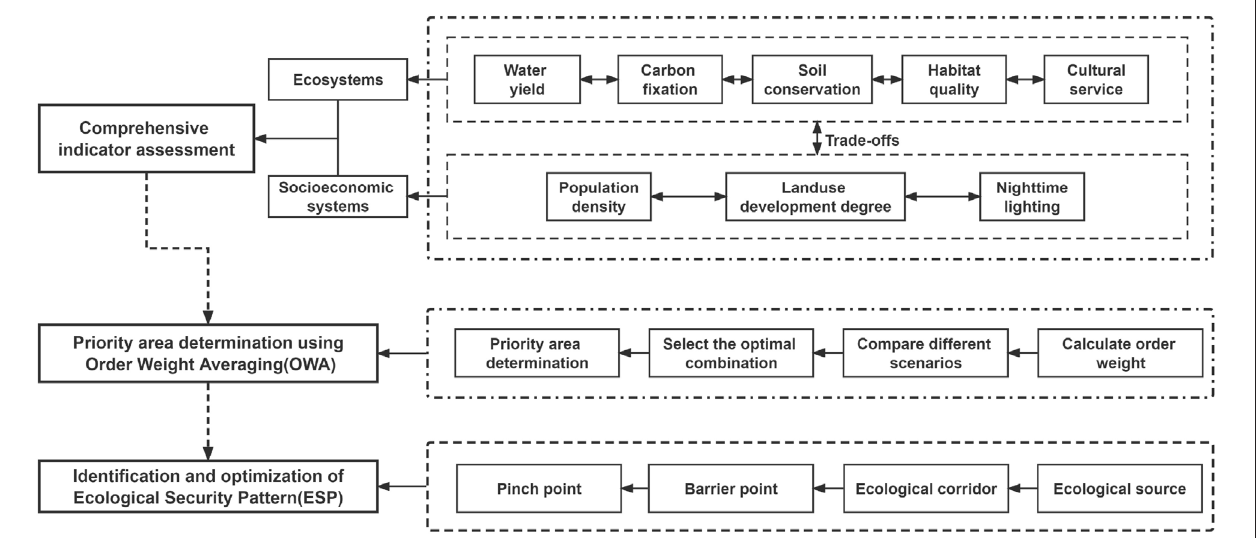
FIGURE 2 | The research